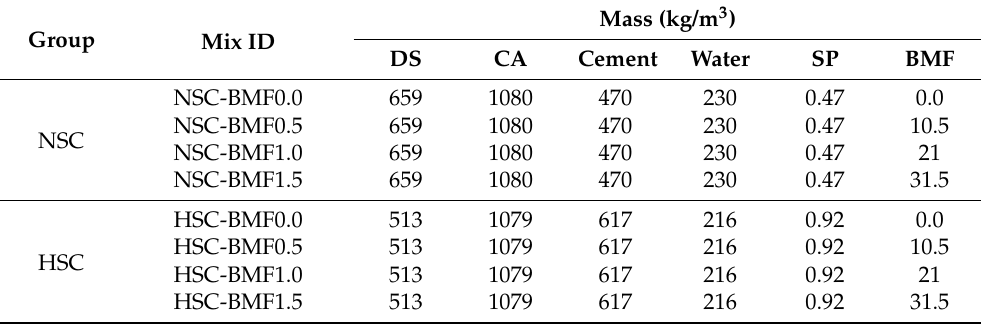
Table 4. Proportions of concrete